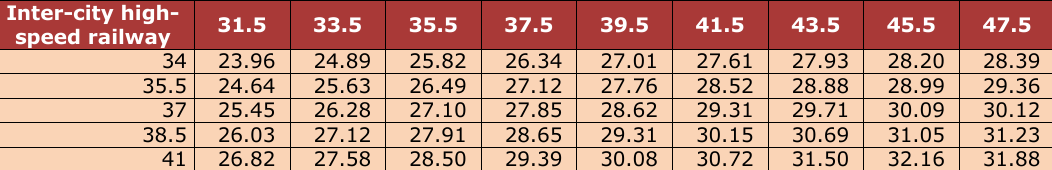
Table 5. Operating earnings of Nanchang-Jiujiang Inter-city High-speed